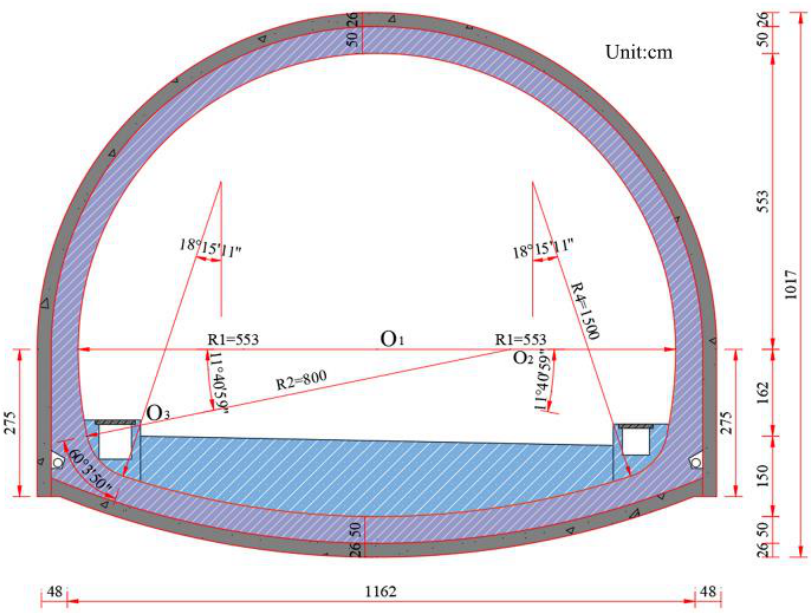
Figure 3. The size of Lingjiao Tunnel.